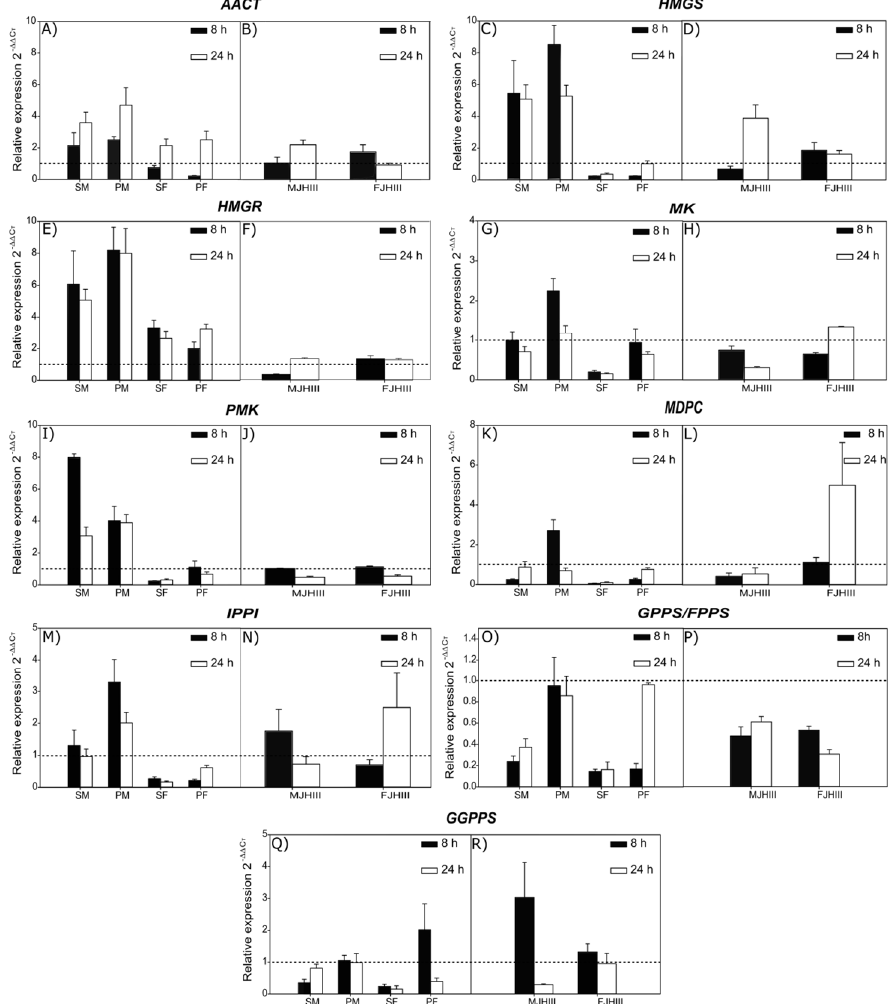
Figure 2. Relative expression of MVA pathway genes calculated by the 2 −ΔΔ C t method in D. rhizophagus pre‐emerged adults fed on phloem ( A , C , E , G , I , K , M , O , Q ) or treated with JH III ( B , D , F , H , J , L , N , P , R ). SM: solitary males, PM: paired males, SF: solitary females, PF: paired females, MJHIII: males treated with JH III, FJHIII: females treated with JH III. Control levels are indicated with the dashed lines; values > 1 on the y‐axis (2 −ΔΔ C t ) indicate upregulation.